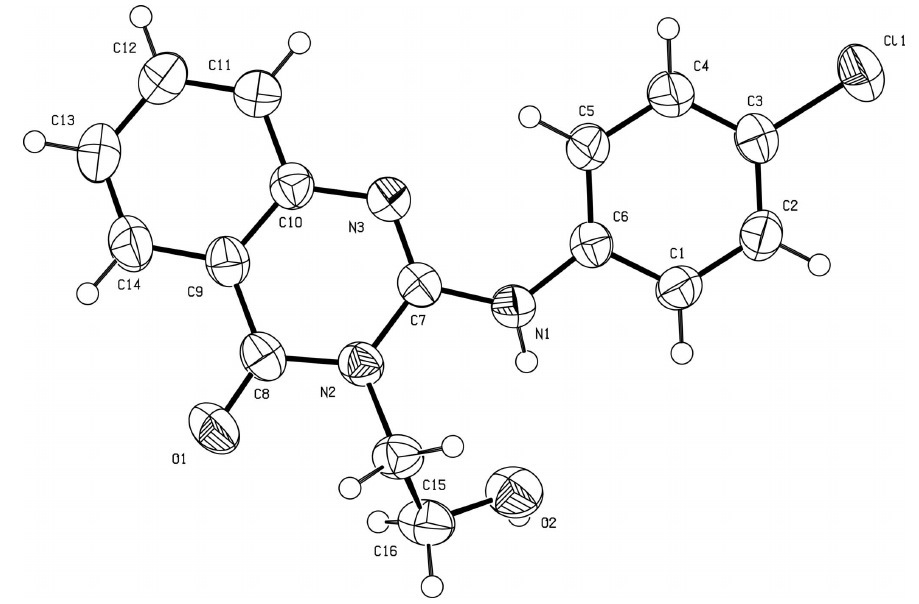
Figure 1 View of the molecule with the atom-labeling scheme. Displacement ellipsoids are drawn at the 50% probability